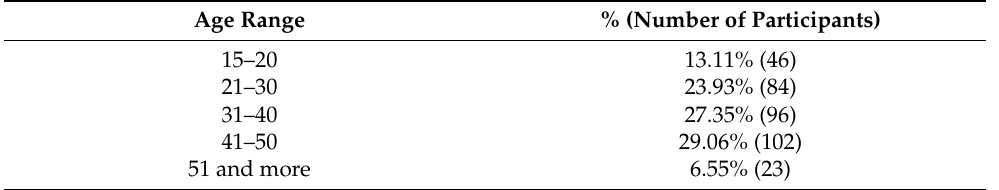
Table 16. Age range.